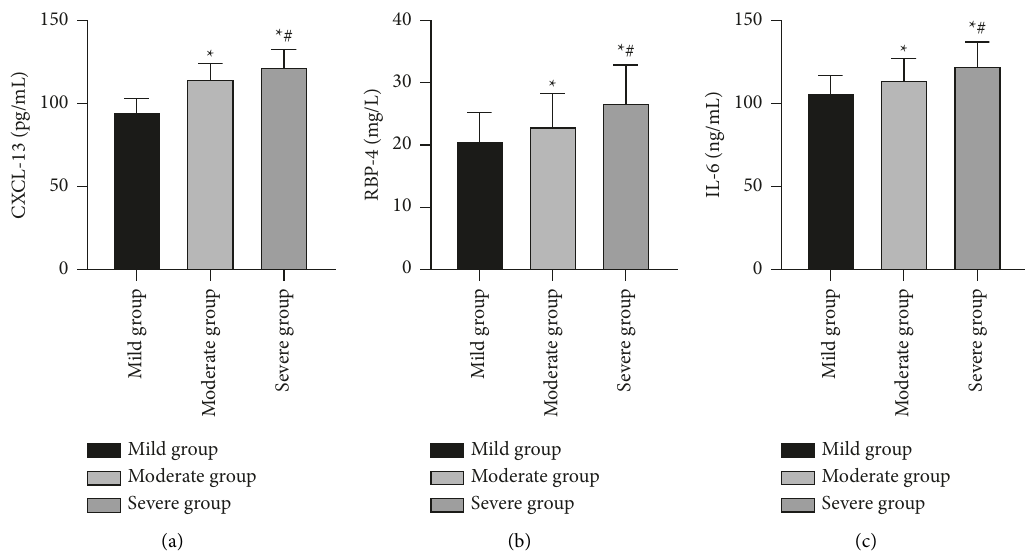
0 . 05. (a) Represents a comparison of CXCL-13 levels; (b) represents a comparison <